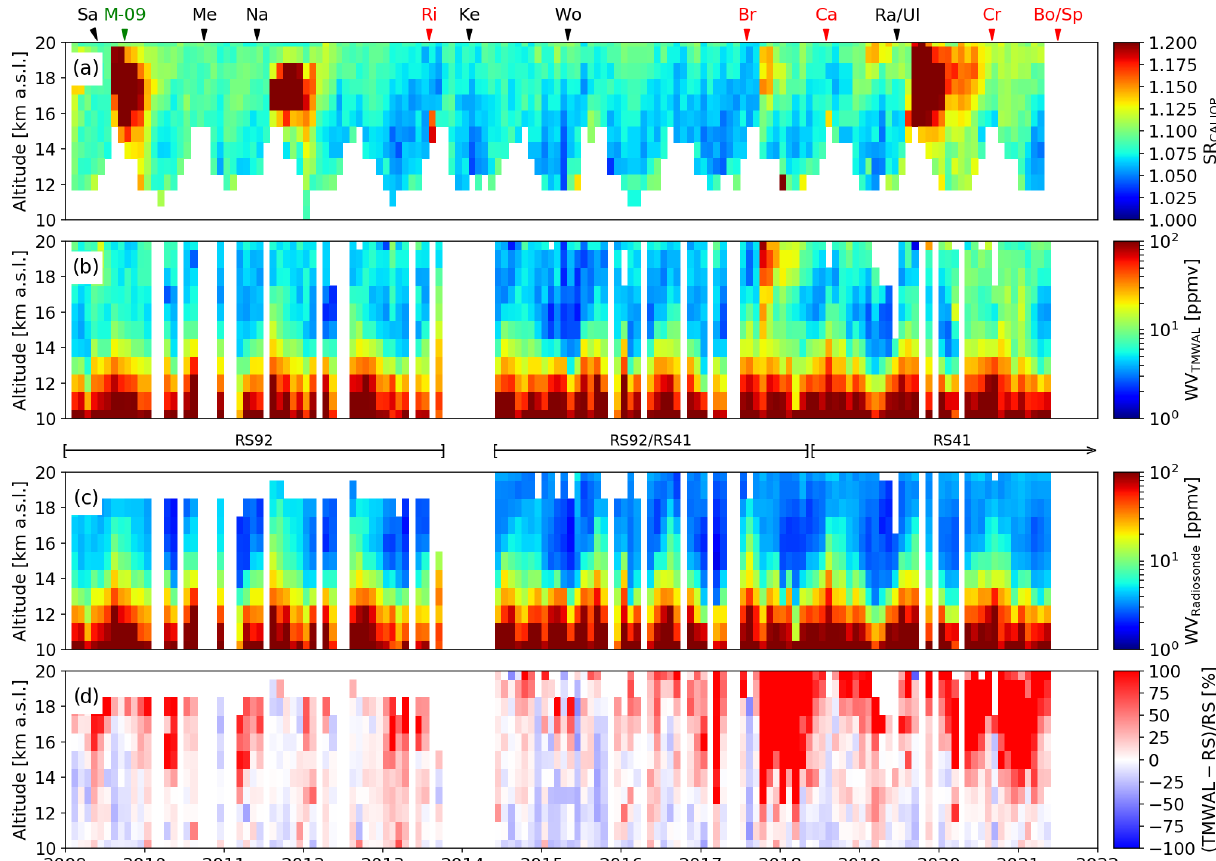
Figure 1. (a) Monthly and zonally averaged time series of aerosol scattering ratio derived from CALIOP between 2009 and the end of 2021 at 30–35 ◦ N (Table Mountain Facility). Major eruptions (black triangles), PyroCb events (red triangles), and the MOHAVE-2009 (green triangle) field campaign are indicated at the top of the plot (see Table 1). (b) Monthly averaged TMWAL water vapor mixing ratio measurements during days where radiosonde launches were available. (c) Monthly averaged radiosonde water vapor mixing ratio. The periods where the RS92, RS92 and RS41, and RS41 radiosonde were used are indicated on top of the plot. (d) Relative difference between TMWAL and the